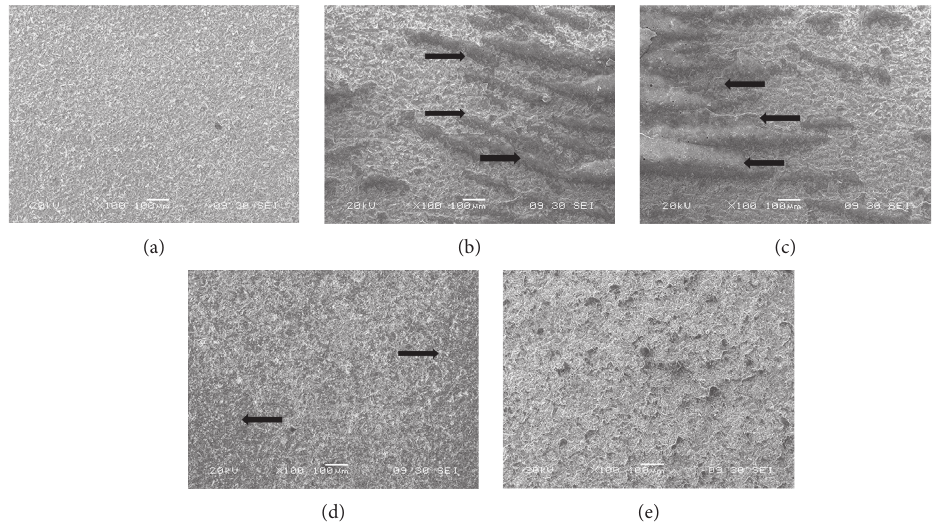
Figure 2: SEM microphotographs of the fracture surface of titanium specimens: (a) control group, (b) 10g/L MgSiF MgSiF 6 group, (d) 30g/L MgSiF 6 group, and (e) 40g/L MgSiF 6 group. Bar � 100 μ m. The residual porcelain is indicated by arrows.